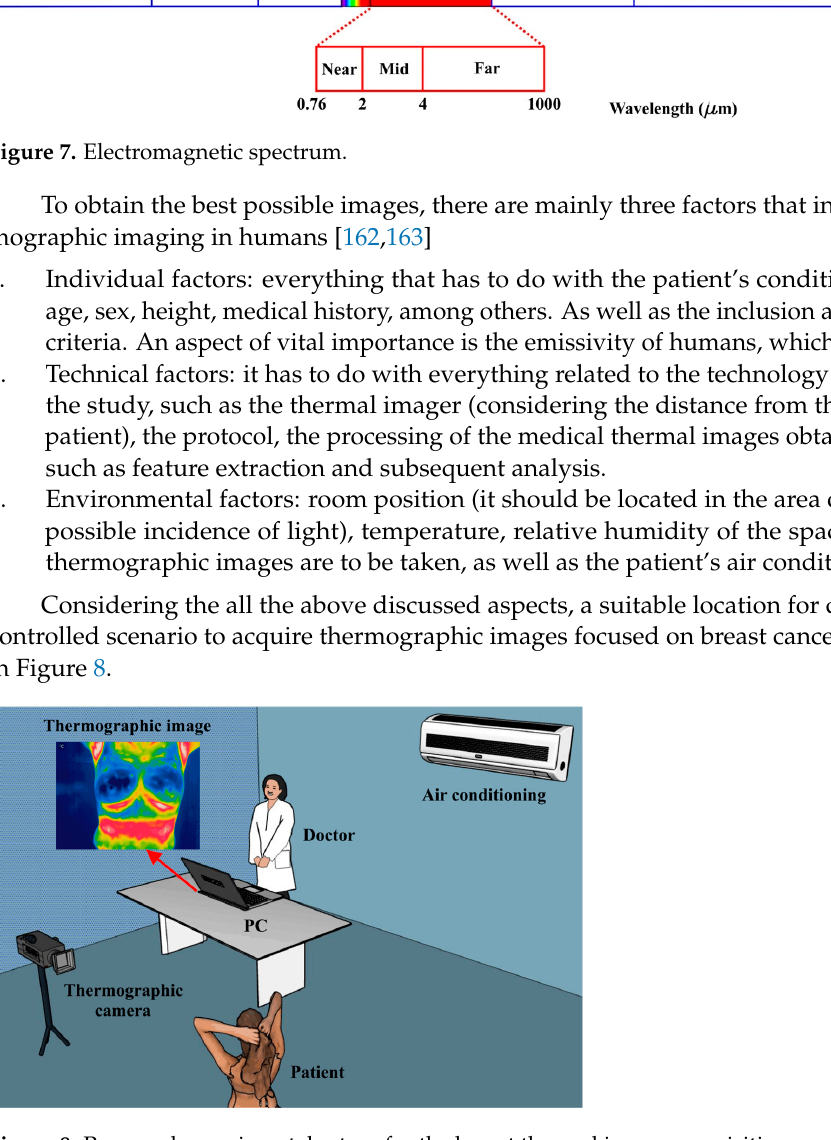
Figure 8. Proposed experimental set up for the breast thermal images acquisition.